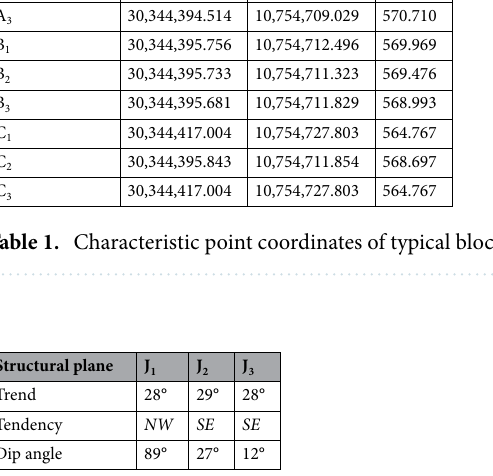
Table 2. The occurrence of J 1 ~ J 3 structural